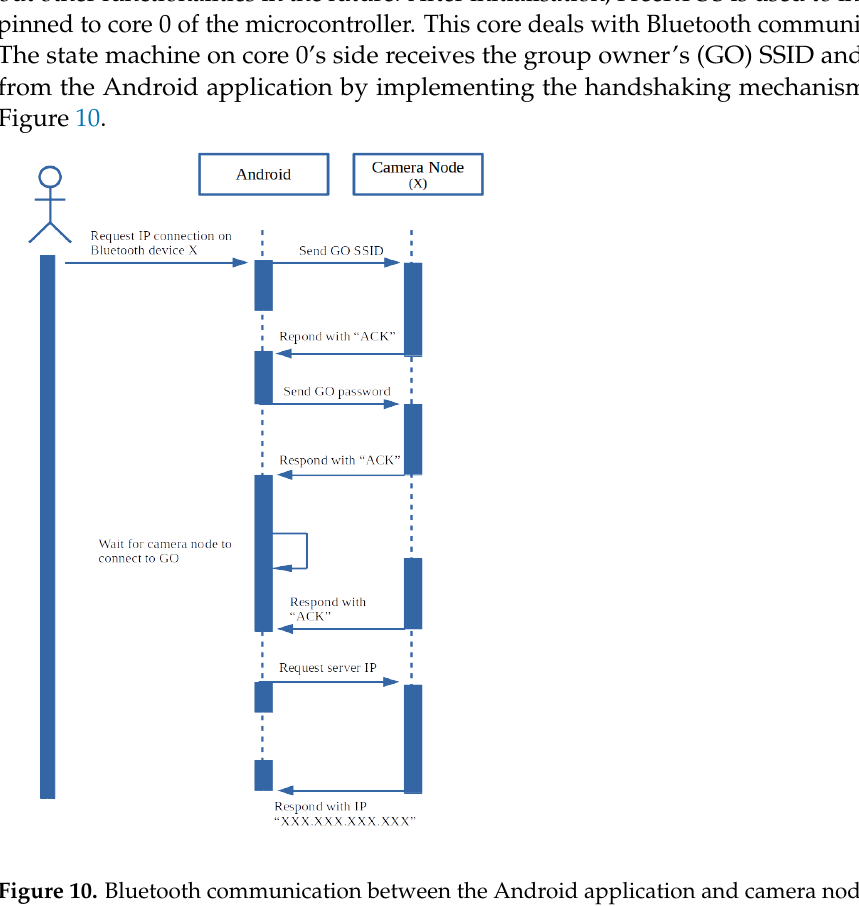
Figure 10. Bluetooth communication between the Android application and camera